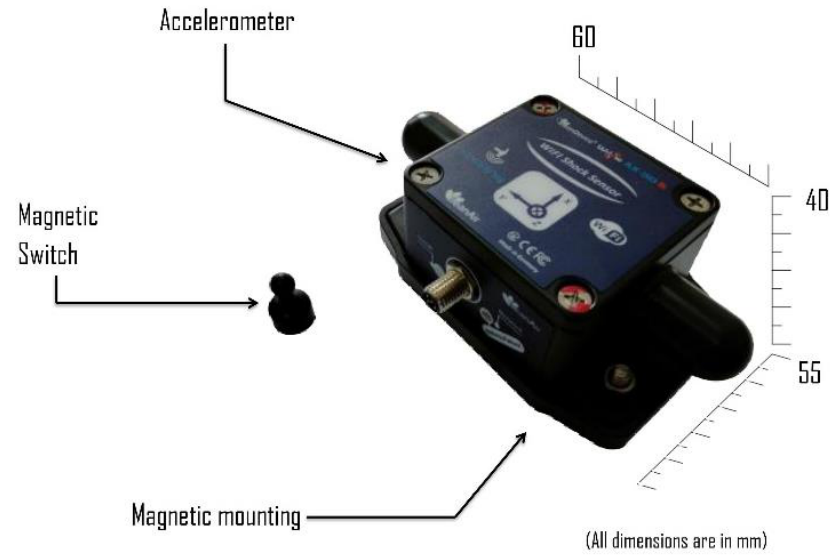
Figure 3. BeanDevice Wilow AX-3DS, MEMS Accelerometer.